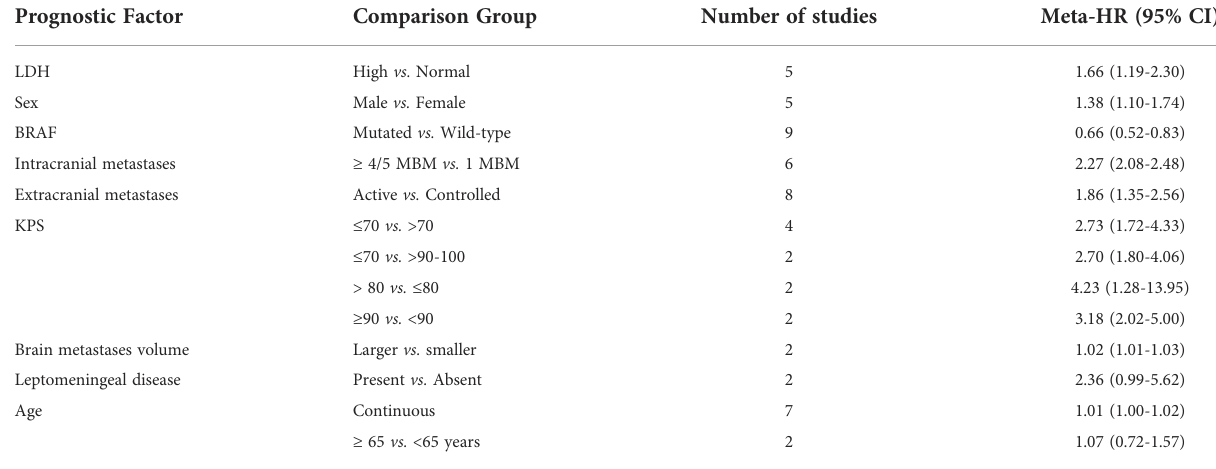
TABLE 3 Meta-analysis hazard ratios (Meta-HR) for prognostic factors of overall survival (OS) among patients with MBM. Prognostic